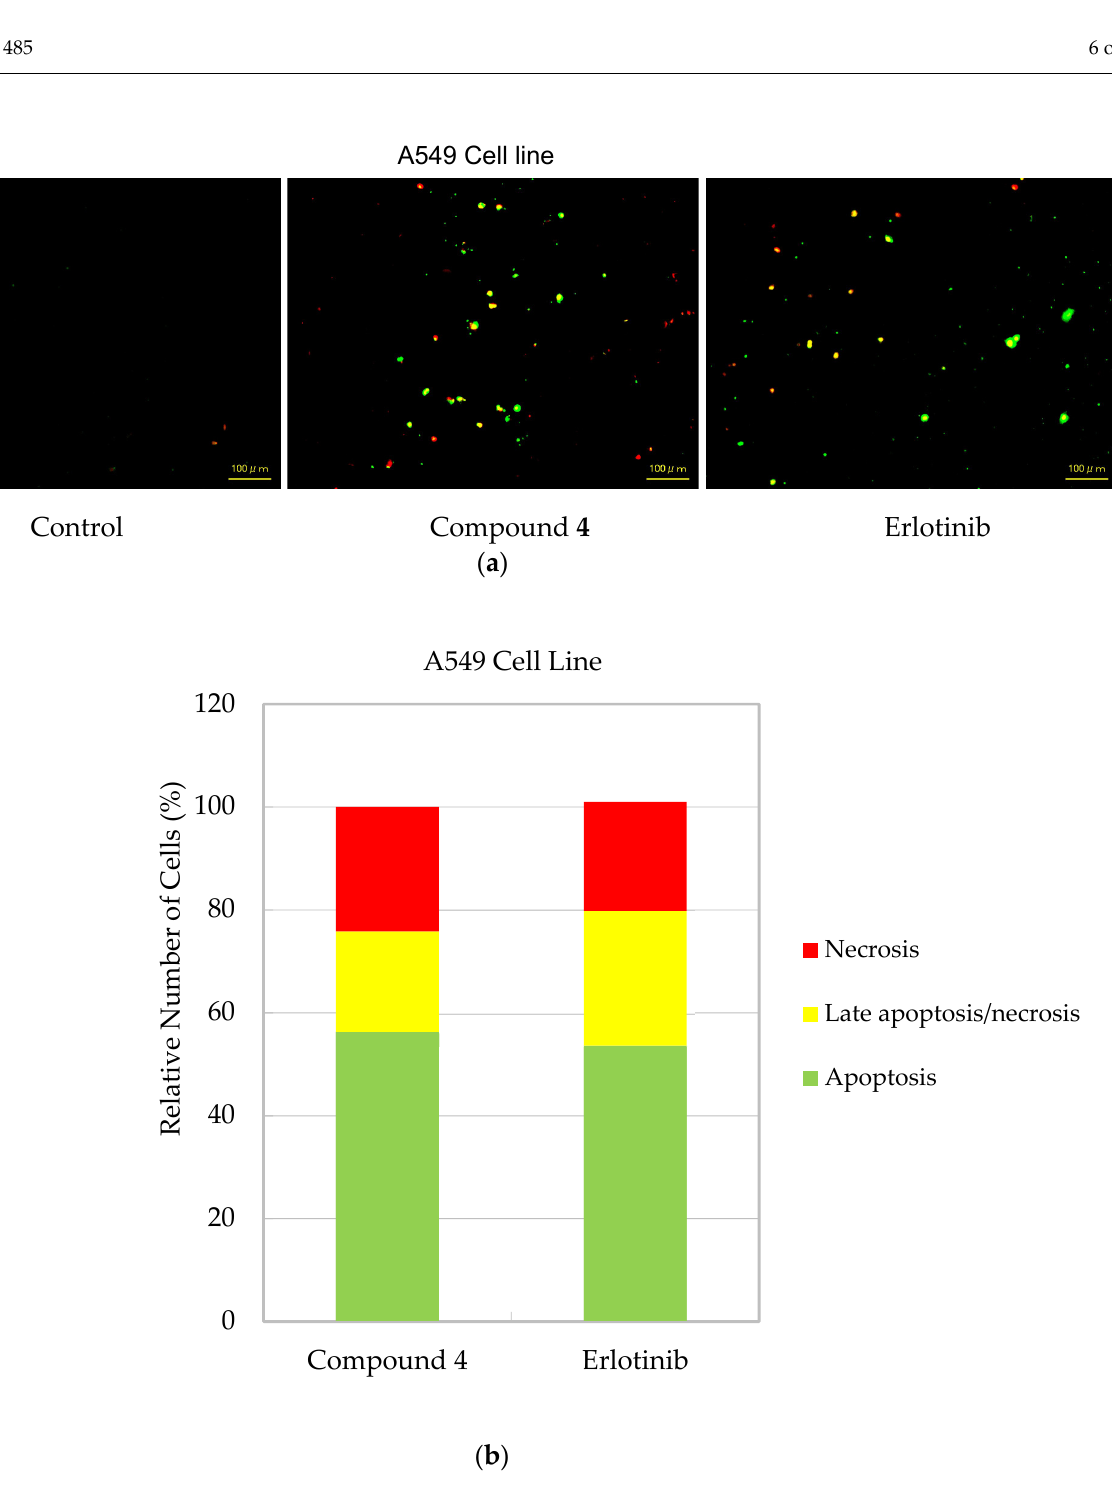
Figure 3. The apoptotic effects of compound 4 and erlotinib on A549 cells. ( a ) Coloring phenomenon of the A549 cell line following exposure to IC 50 concentrations of compound 4 and erlotinib for 15 h. ( b ) The percentage of apoptotic (green), necrotic or late apoptotic (both green and red), and necrotic (red) cells was quantified by analyzing 100 randomly chosen stained cells in each experiment. All descriptive data were expressed as the Mean ± SD. All experiments were repeated three times.